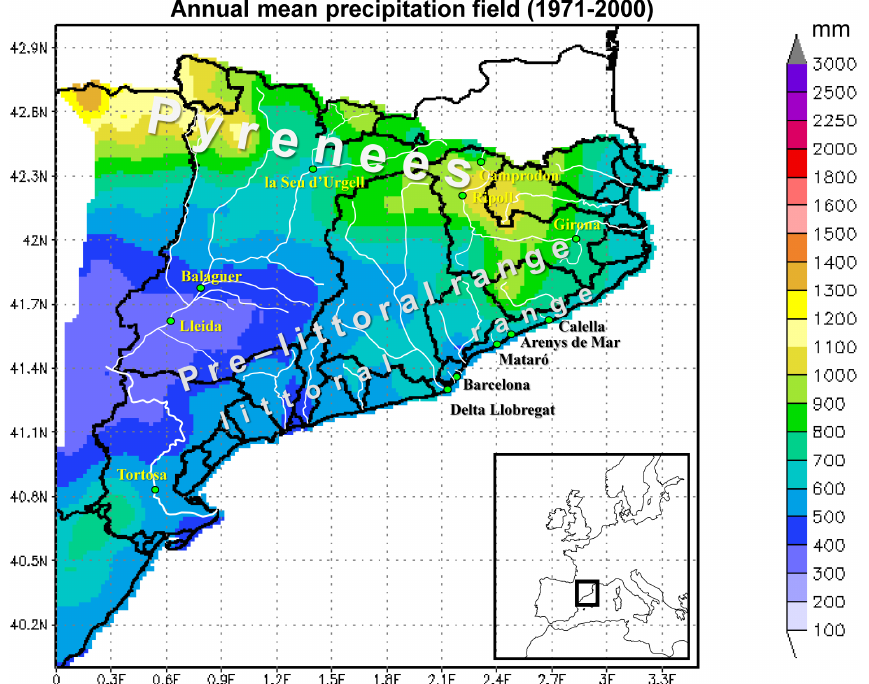
Figure 1. Annual mean precipitation field for Catalonia (1971–2000) at 5km resolution and computed from a high-density network of observations (adapted from Altava-Ortiz, 2010). The three main mountain ranges of Catalonia are shown over the map. The Catalan river basins and their related main water courses are also displayed. Finally, the location of the analysed flood chronologies is also